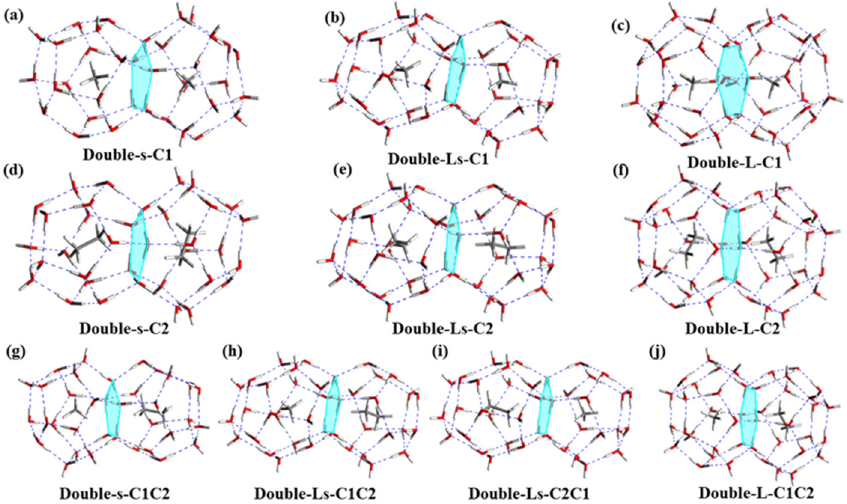
Figure 3. The structural configuration of ( a , d , g ) Double-s, ( b , e , h , i ) Double-Ls, and ( c , f , j ) Double-L, shared with pentagon, pentagon, and hexagon water rings, respectively.